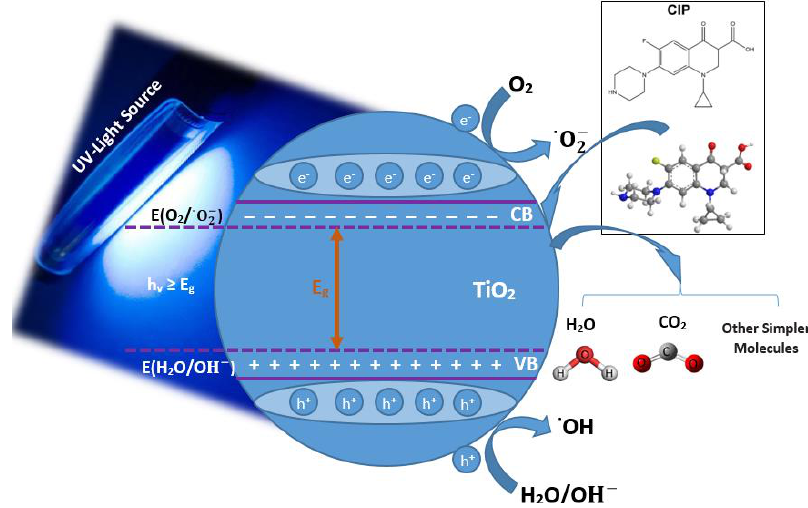
Figure 11. The proposed mechanism for the degradation of CIP using N-TiO 2 .